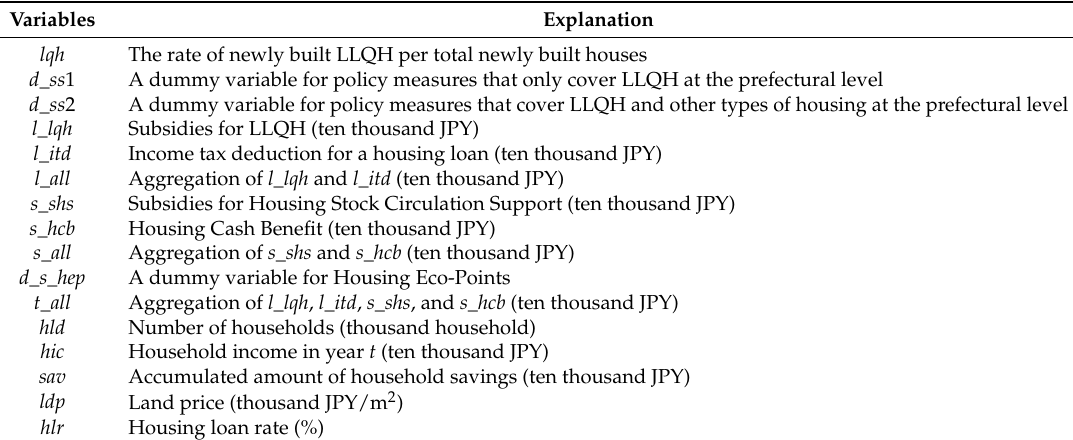
Table 3. Summary of variables and their